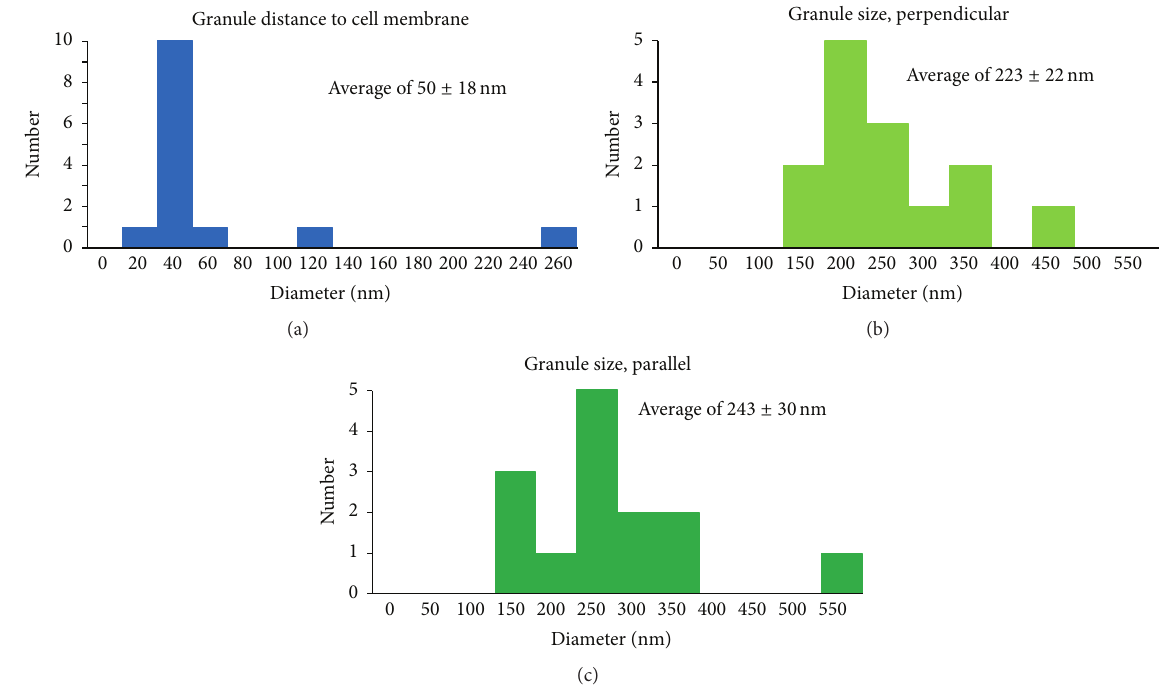
Figure 3: Size and location distribution of granules in A. fulgidus cells. (a) Distance of granules from the cell membrane. (b) Diameter of granules perpendicular to the cell membrane. (c) Diameter of granules parallel to the cell membrane.